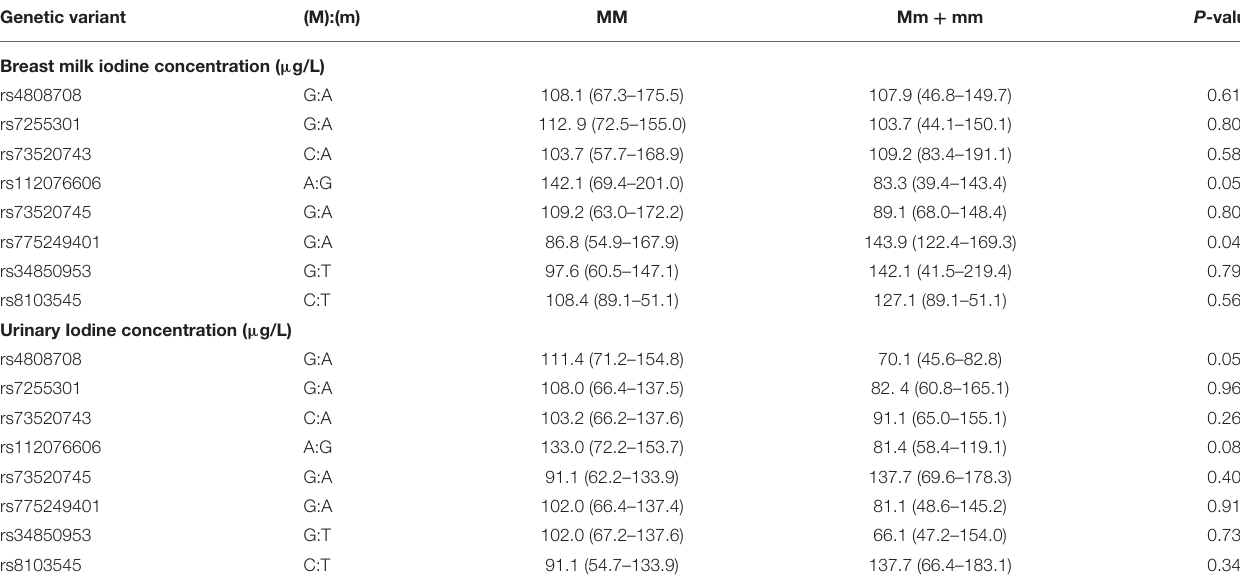
TABLE 4 | Association of SLC5A5 variants with breast milk iodine concentrations and urinary iodine concentrations ( n = 55). Genetic